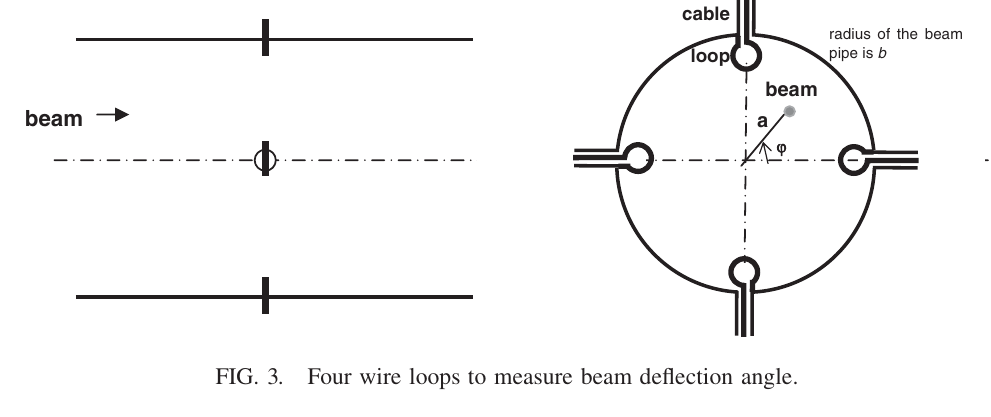
FIG. 3. Four wire loops to measure beam deflection angle.